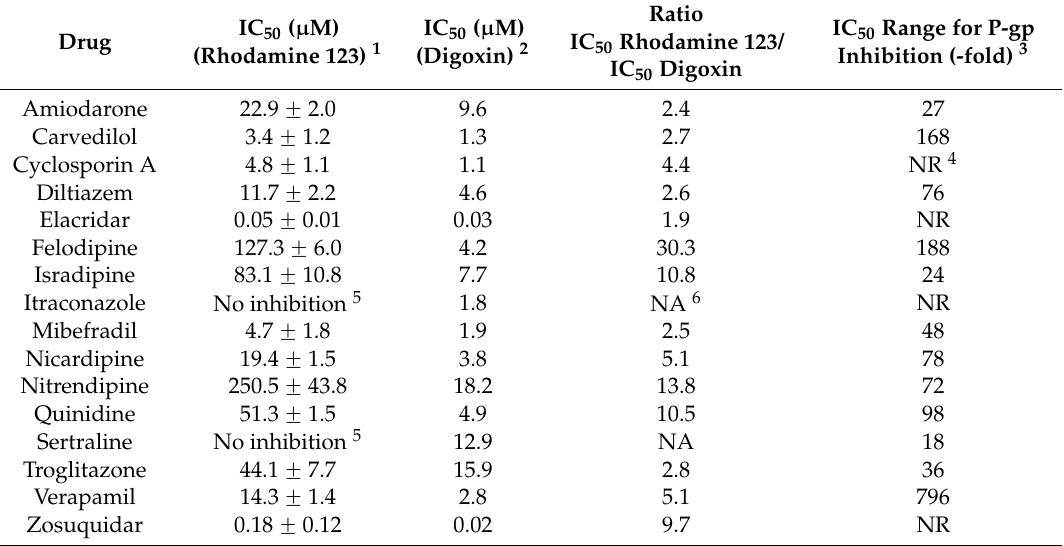
Table 1. P-gp inhibitory potential (IC 50 values) based on rhodamine 123 accumulation